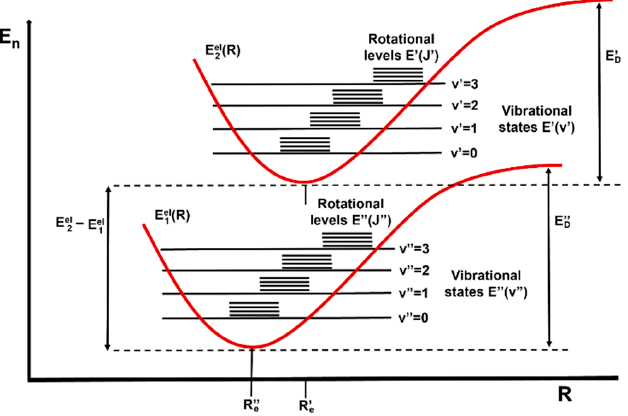
Figure 5. Schematic representation of electronic (E el ), vibrational (E(v)) and rotational (E(J)) ground and excited states of a diatomic molecule.